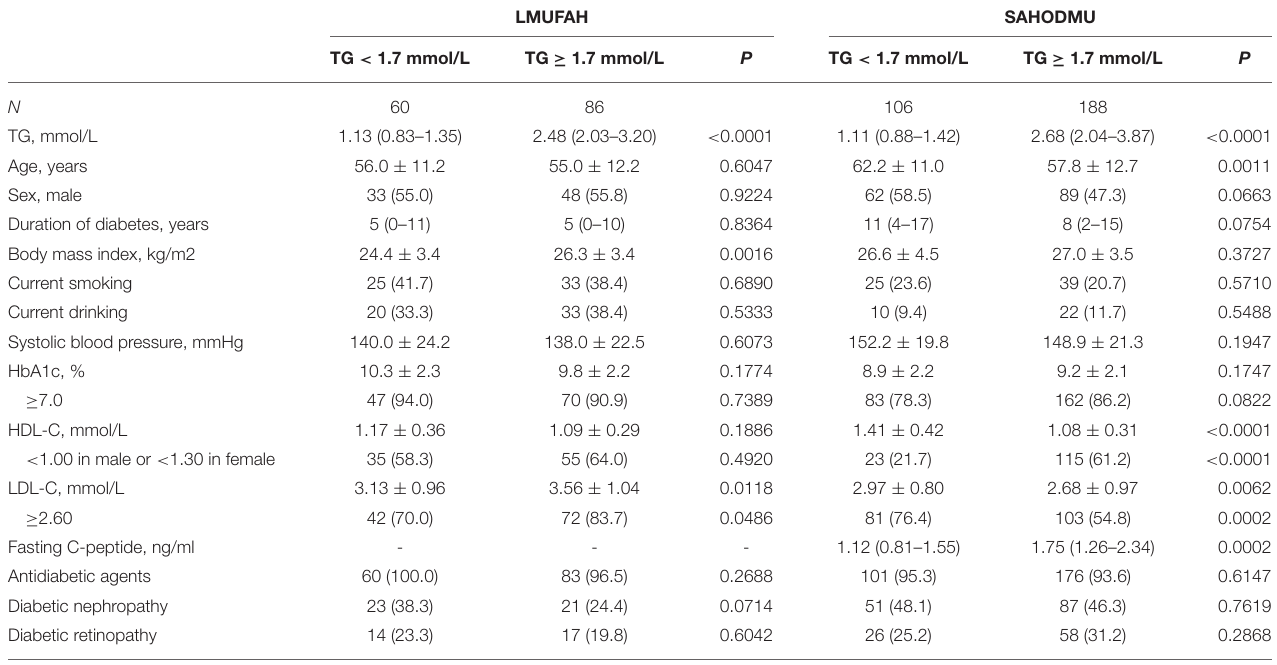
TABLE 1 | Clinical and biochemical characteristics of participants in two cohorts according to TG levels.